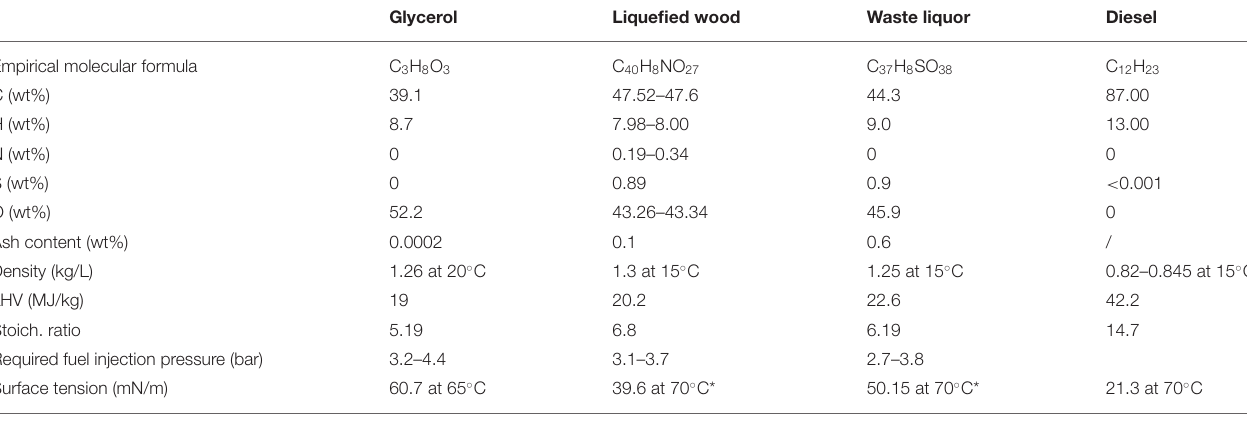
TABLE 1 | Properties of investigated fuels.